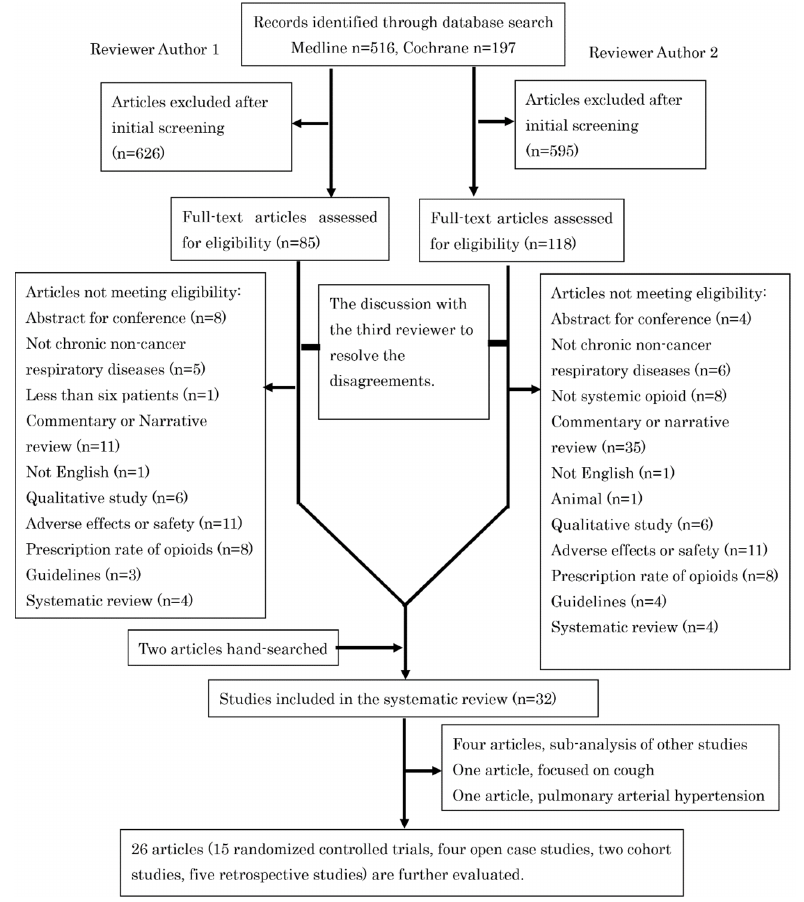
Figure 1. The study selection process of this systematic review.